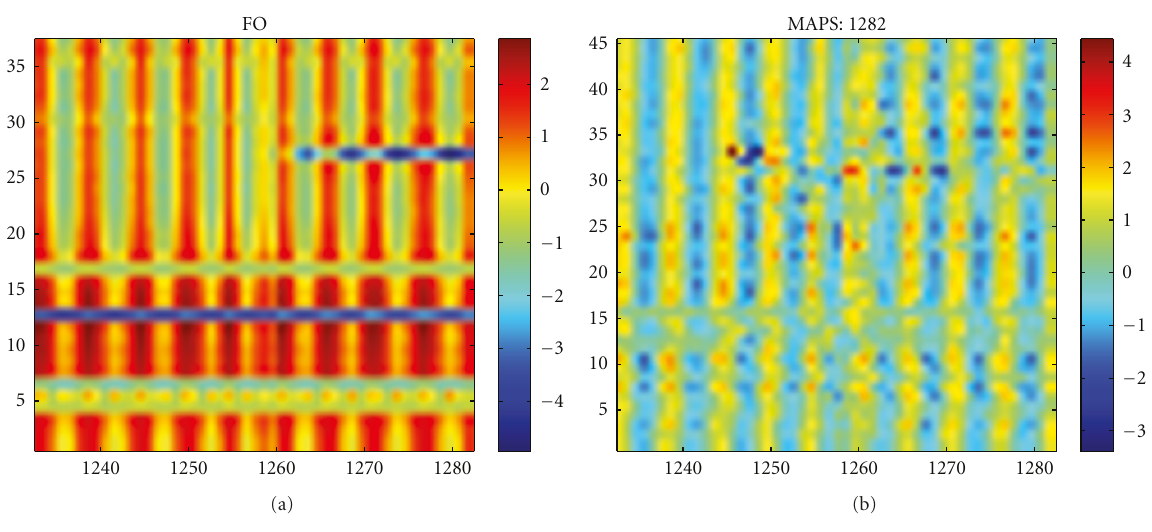
Figure 19: Wire 27